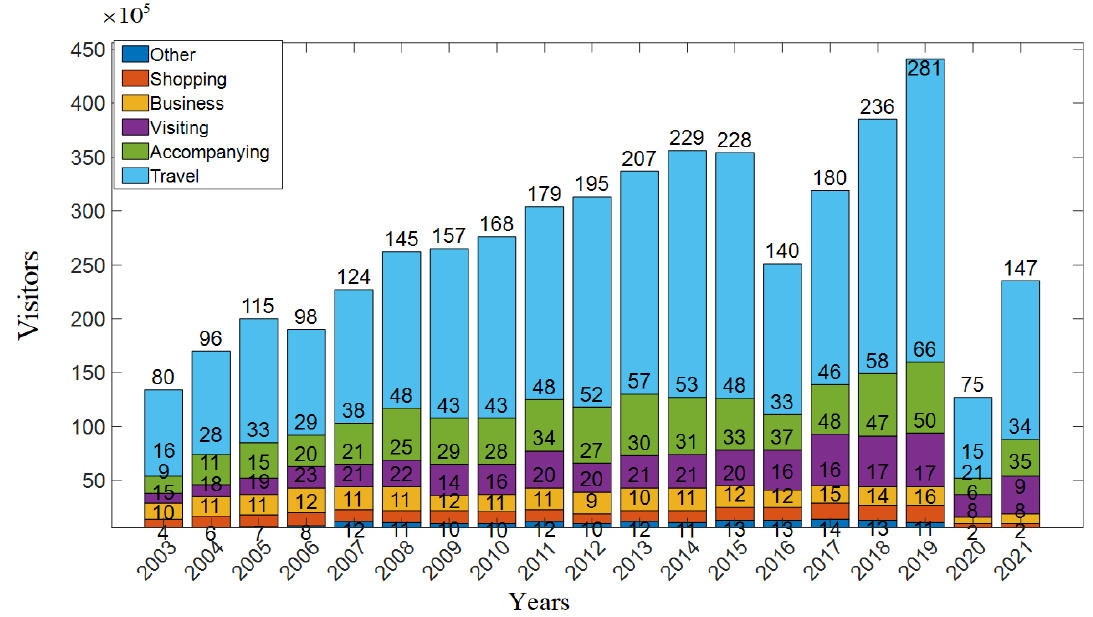
Figure 2. Departing foreign visitors for other, shopping, business, visiting, accommodation, and travel reasons.